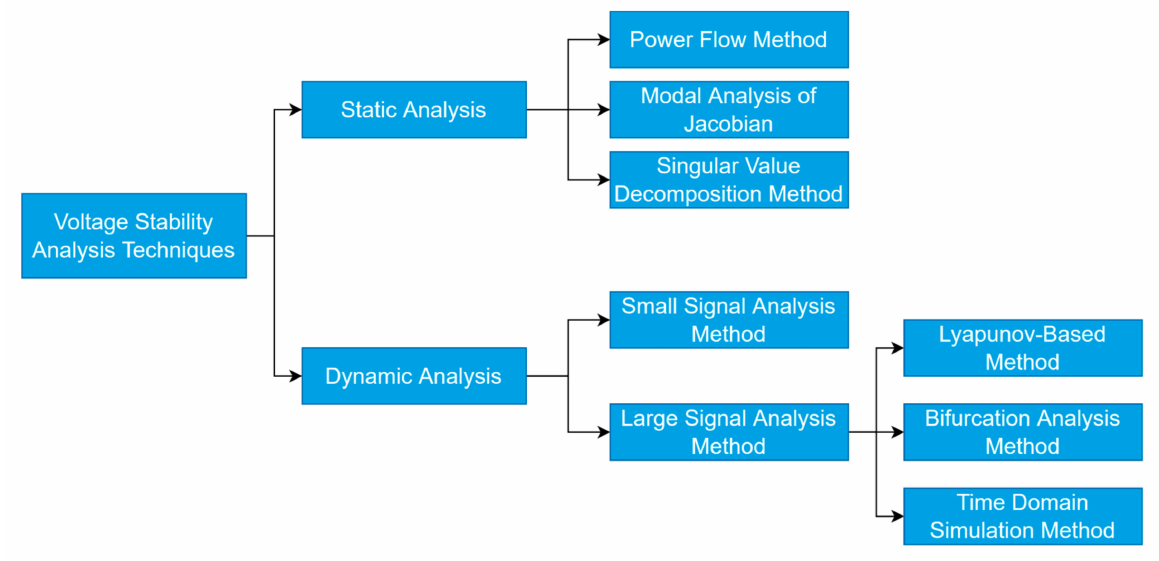
Figure 2. Classification of voltage stability analysis